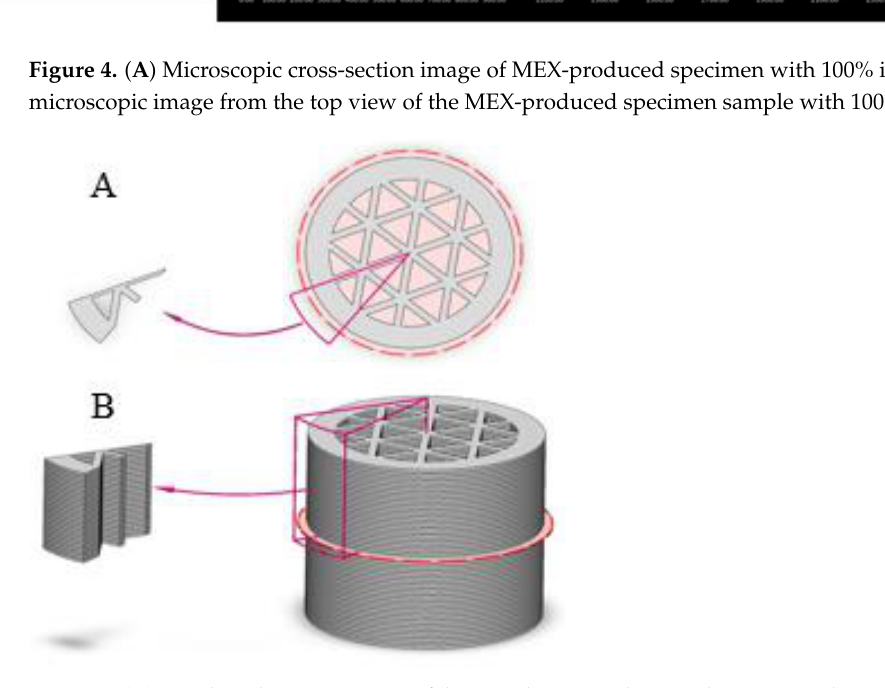
Figure 5. ( A ) Dividing the cross-section of the sample into twelve equal symmetrical parts; ( B ) halving the height of one of the symmetrical parts. Table 1. Mechanical properties of the PLA applied in the numerical simulation.